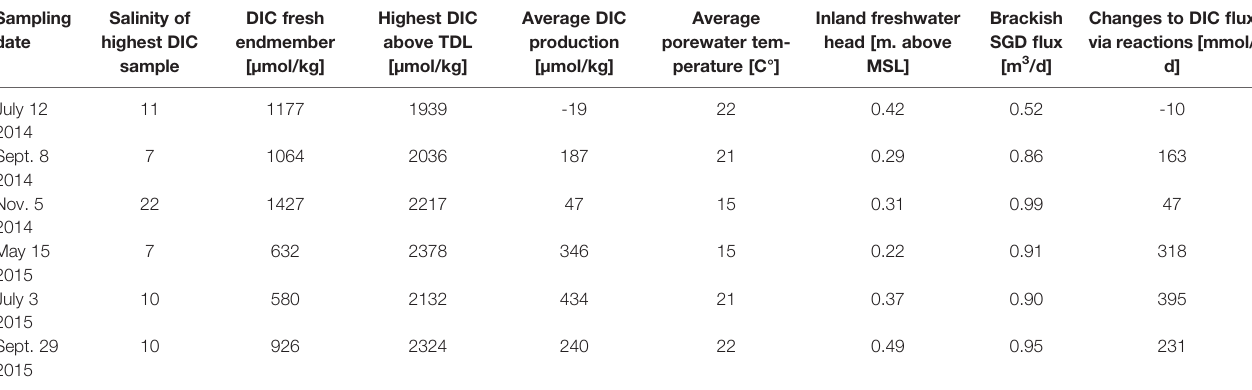
TABLE 1 | Total seasonal DIC production spanning